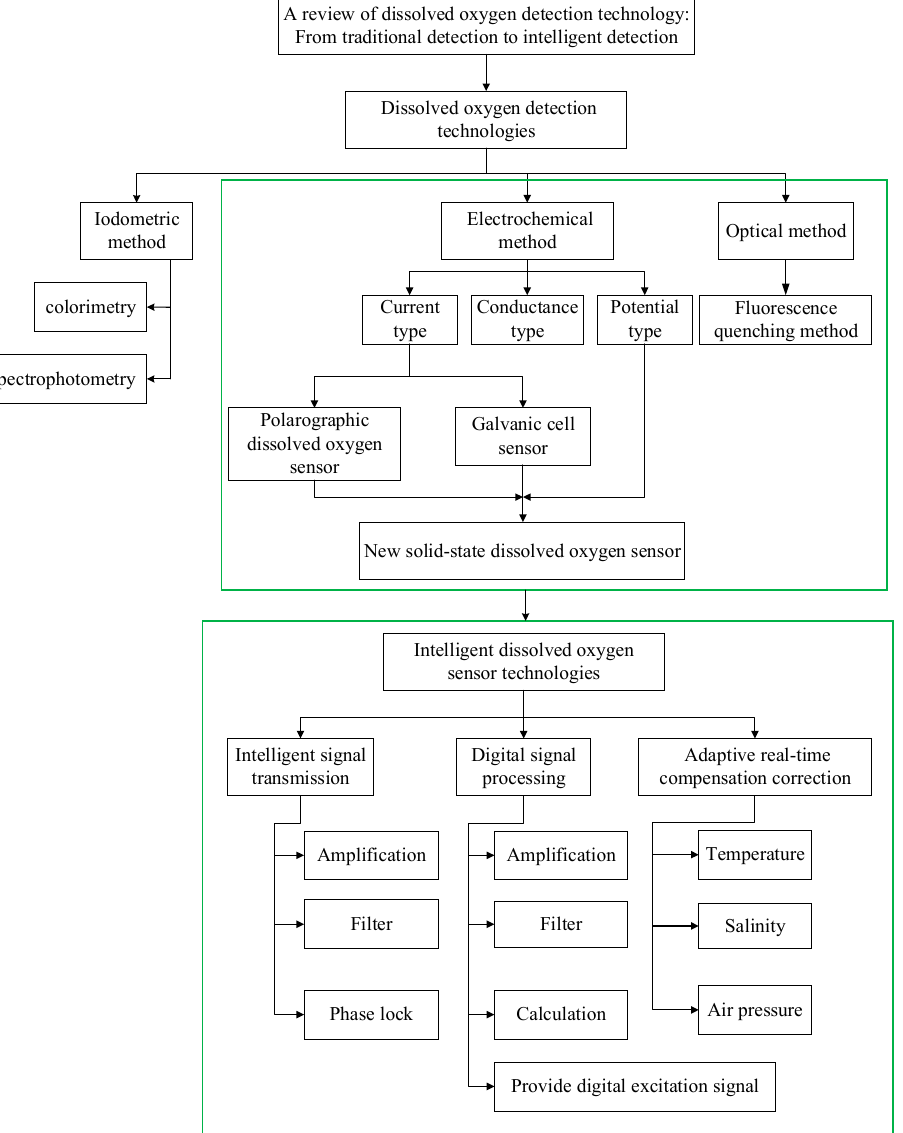
Figure 1. Overview of the article framework.